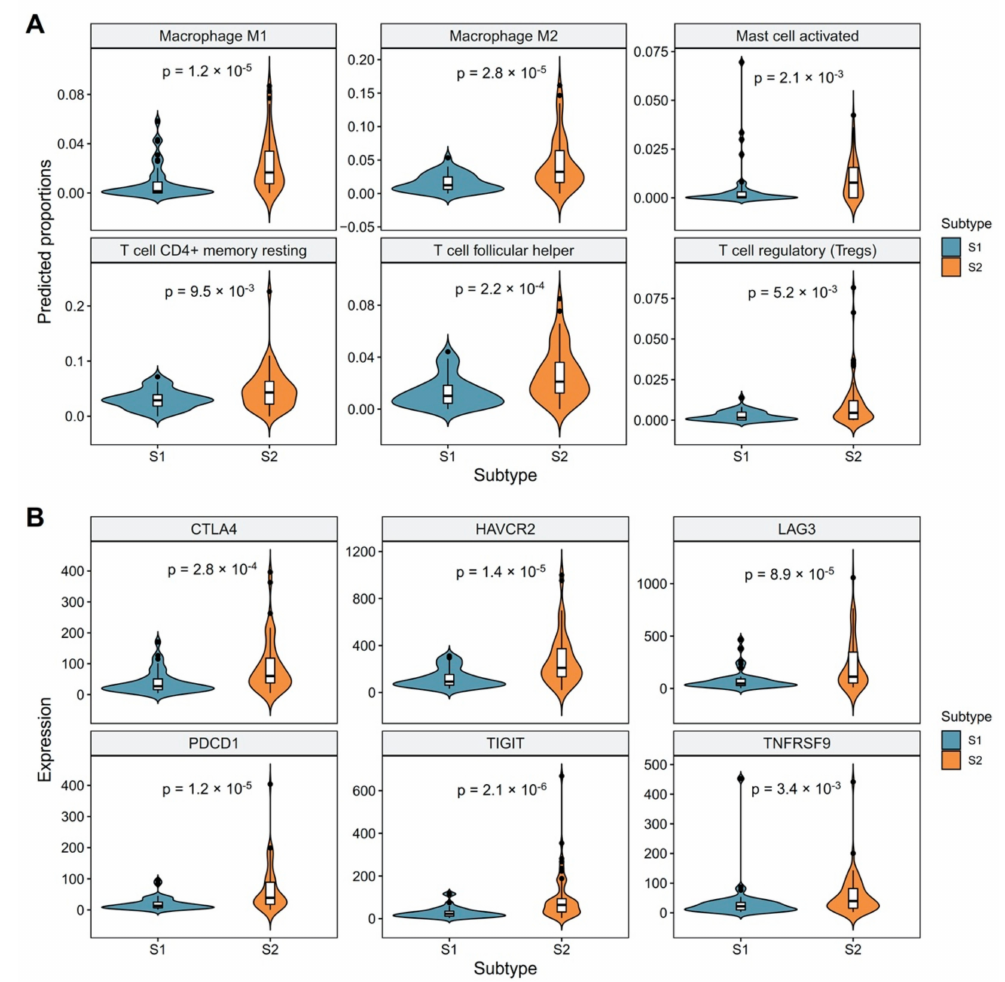
Figure 3. The distinct immune characteristics between two molecular subtypes in the TCGA cohort. ( A ) The predicted proportions of macrophages, activated mast cell, T cell CD4+ memory resting, T cell follicular helper and regulatory T cells (Tregs) between the S1 and S2 subtypes. ( B ) The expression levels of CTLA4 , LAG3 , PDCD1 , HAVCR2 , TIGIT and TNFRSF9 genes between the S1 and S2 subtypes. Wilcoxon rank sum test served as the statistical significance